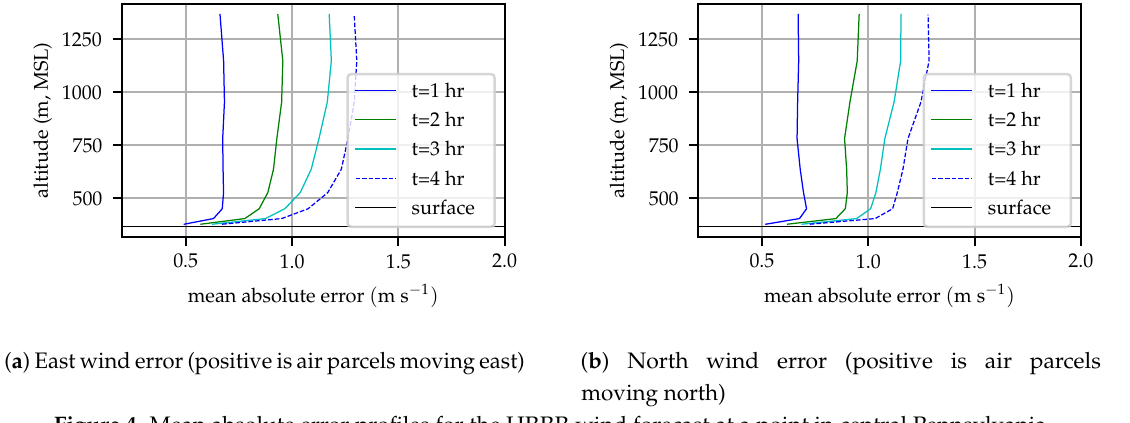
Figure 4. Mean absolute error profiles for the HRRR wind forecast at a point in central